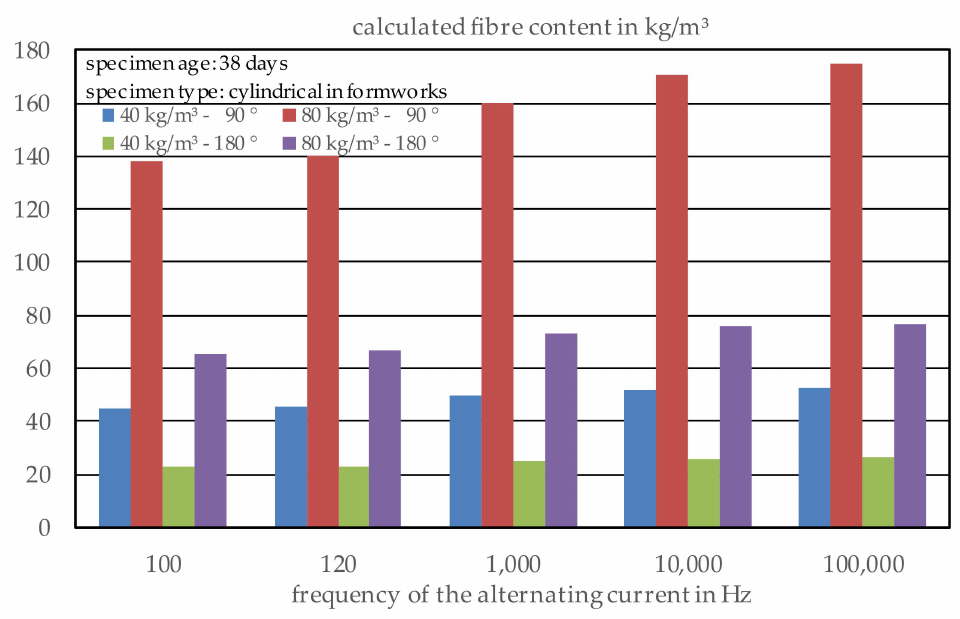
Figure A6. Calculated fibre content of the concrete specimens with different electrode arrays depend- ing on the fibre content and frequency of the alternating current at a specimen age of 38